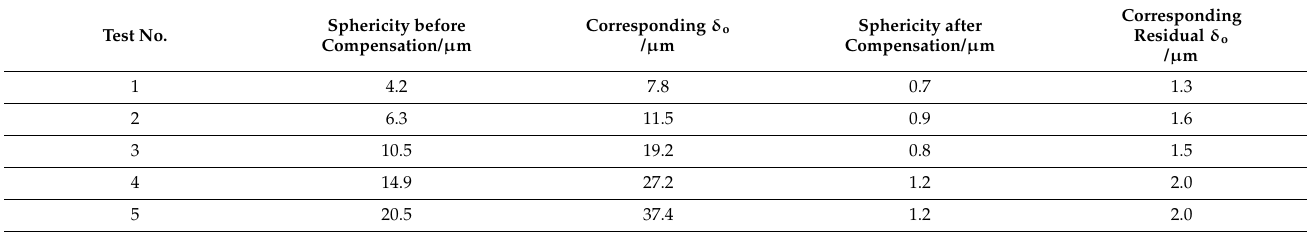
Table 1. Results before and after compensation of height